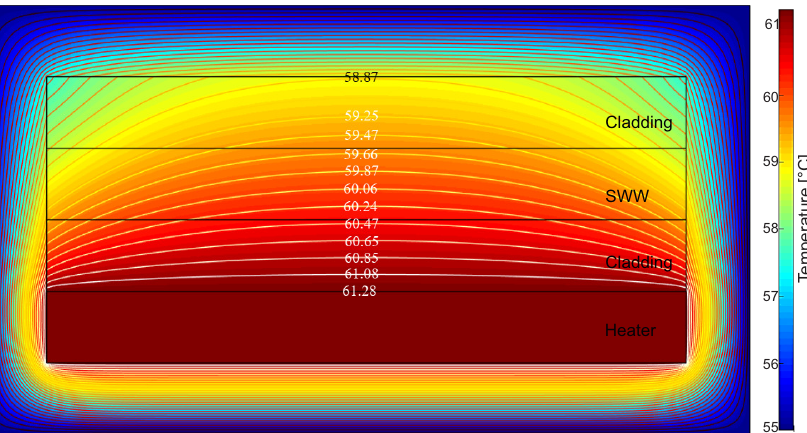
Figure 9. Simulated contour map of the temperature distribution of the cross-section in the middle of an SWW when the heater was at maximum temperature of 61.28 °C. The thickness of each layer is assumed as 50 µm, which corresponds to the thickness of the fiber core we normally use for the SWW experiments. Due to alignment purposes, the SWW should be very close to the bottom so that the thickness of the lower cladding with 50 µm is a realistic assumption. The mesh size used for this simulation was ≈ 3 µ